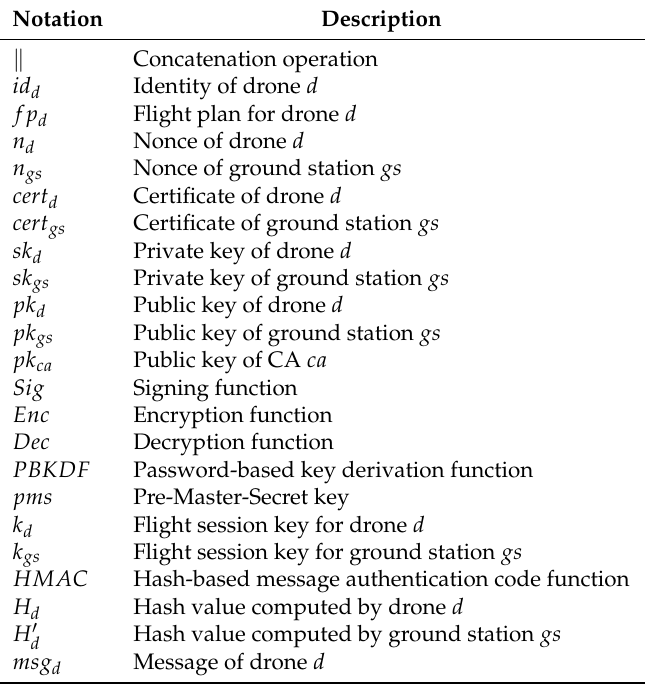
Table 1. Notations used for the protocols in